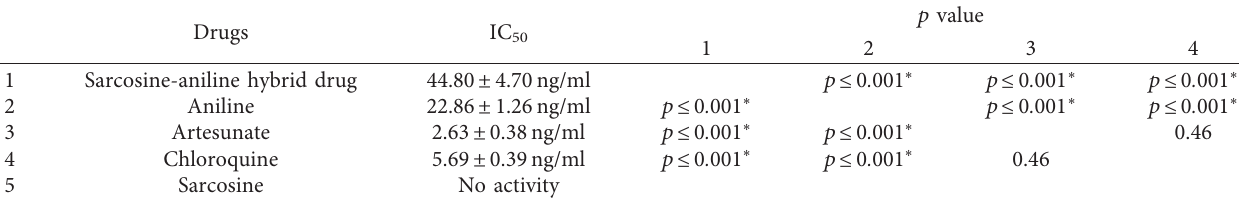
Table 1: IC 50 of sarcosine-aniline hybrid versus control drugs on P. falciparum 3D7 strains.